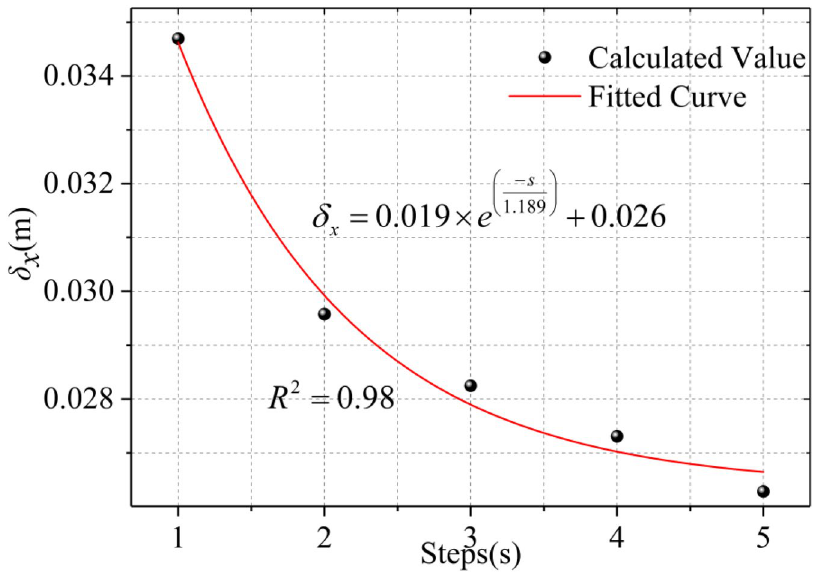
Figure 19. Relationship between step-by-step excavation steps and maximum horizontal displacement.